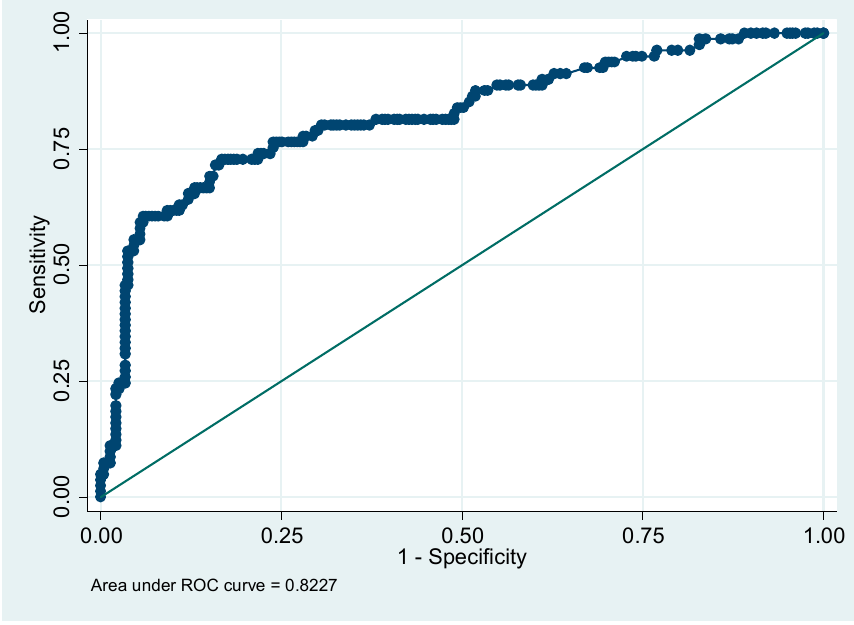
Figure 4. Receiving operating characteristic curve for the nomogram.